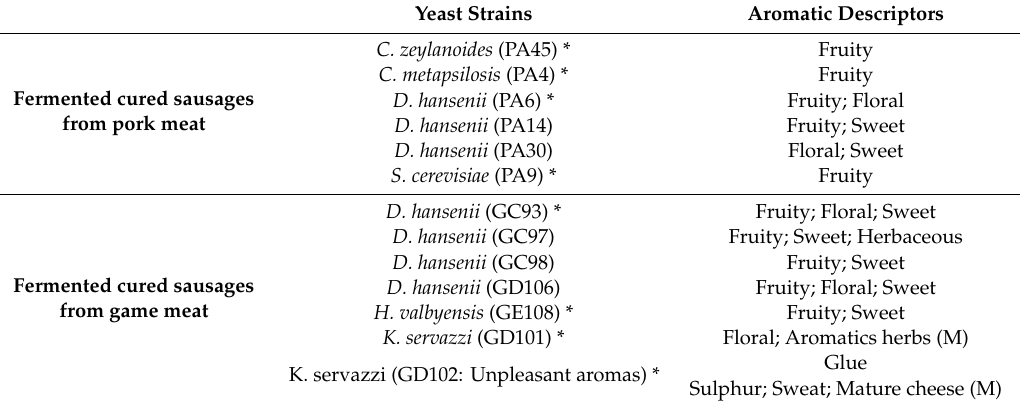
Table 4. Olfactory sensory descriptors found by the taster in some of the yeast strains studied. Those strains selected for gas chromatography (GC) analysis are marked with